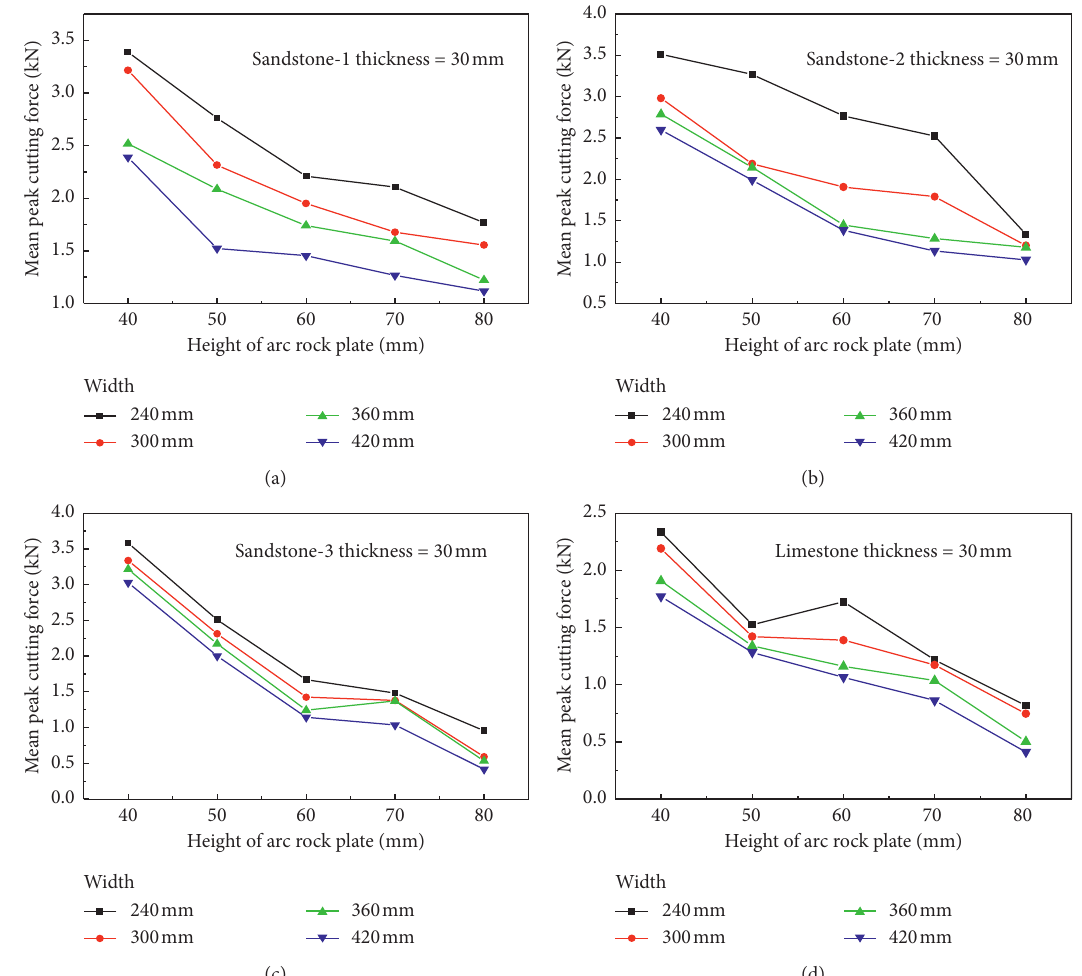
Figure 13: The variation on mean peak cutting force with various height of rock plate.